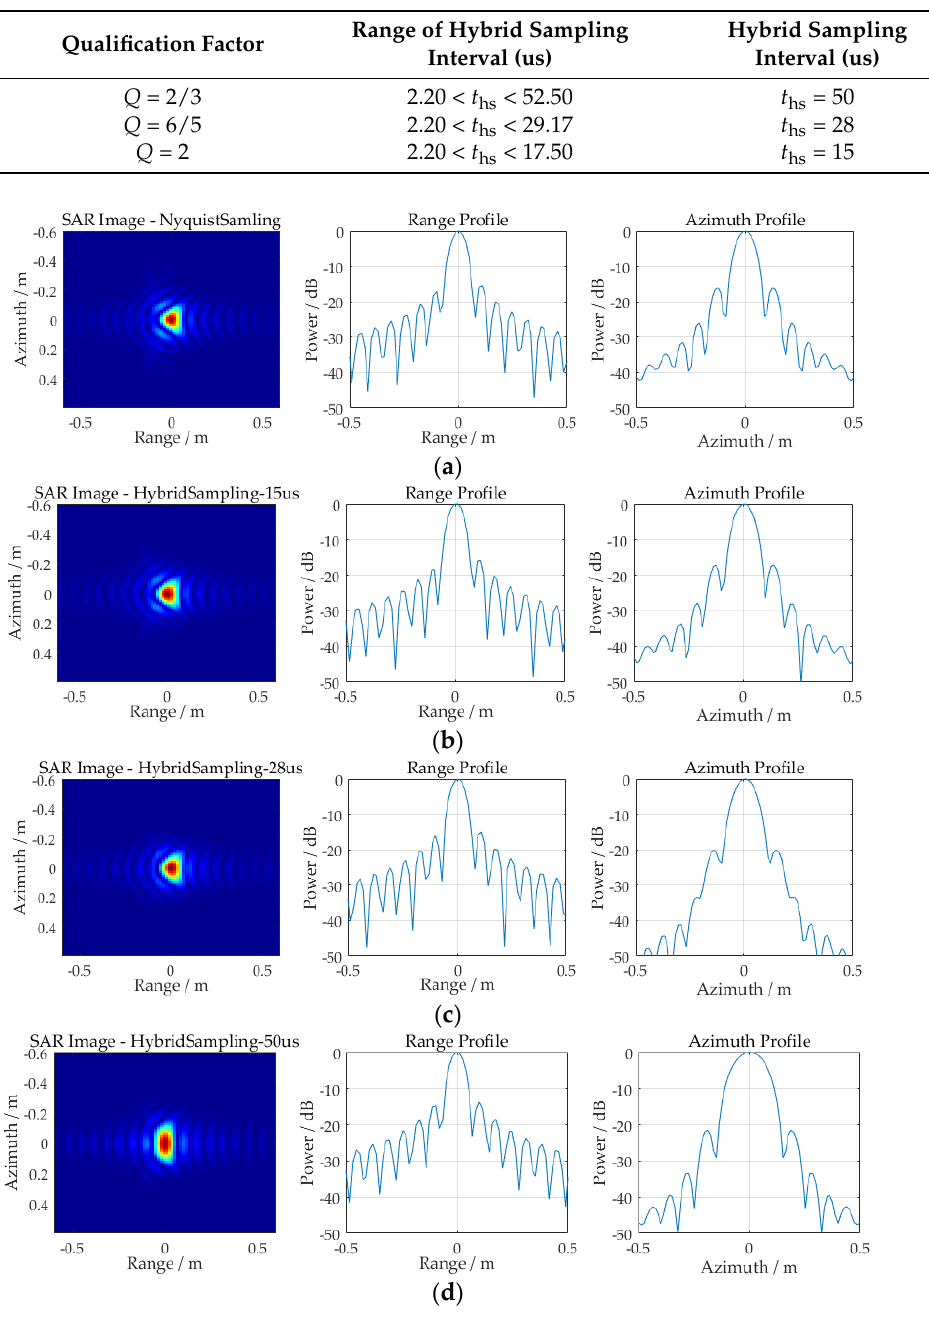
Figure 5. The SAR simulated results of single point target with different Q factors: ( a ) Nyquist real-time sampling; ( b ) Q = 2, 𝑡 (cid:2918)(cid:2929) = 15 us; ( c ) Q = 6/5, 𝑡 (cid:2918)(cid:2929) = 28 us; ( d ) Q = 2/3, 𝑡 (cid:2918)(cid:2929) = 50 us.